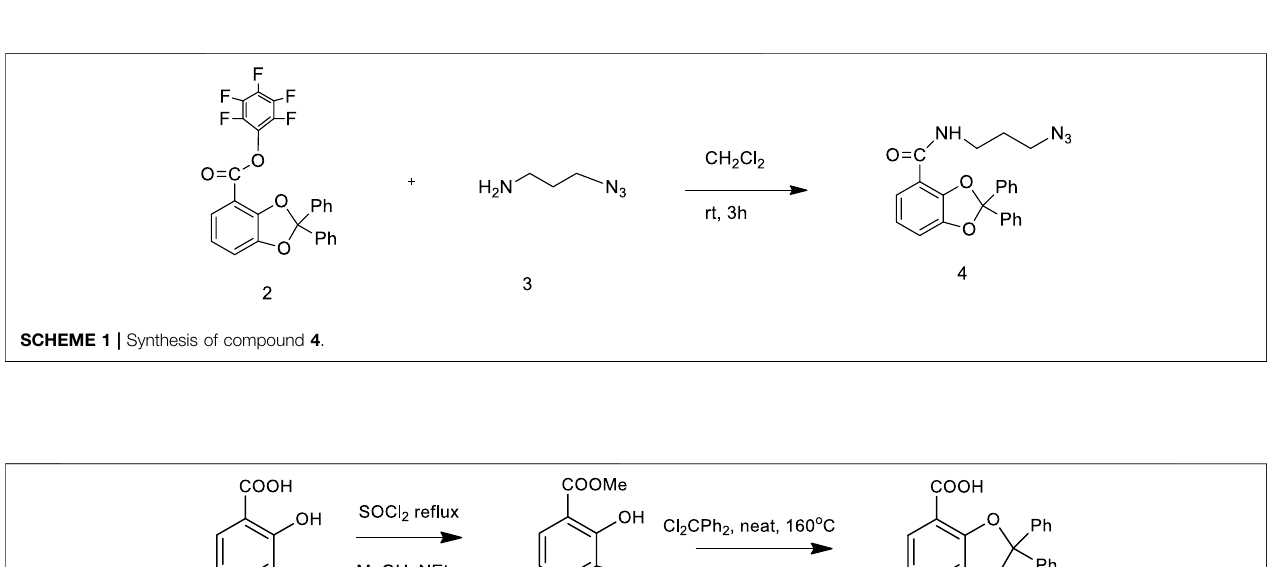
FIGURE 10 | In fl uence of catechol – zingerone conjugate 1 treatment on (A) Hemocompatibility, (B) cell cytotoxicity, and (C) serum susceptibility against P. aeruginosa .